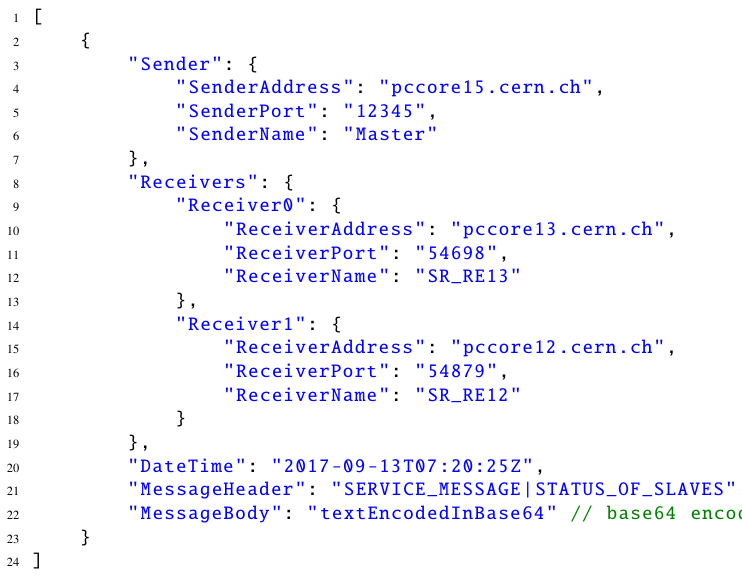
Figure 3. The provided services widget of the DIALOG